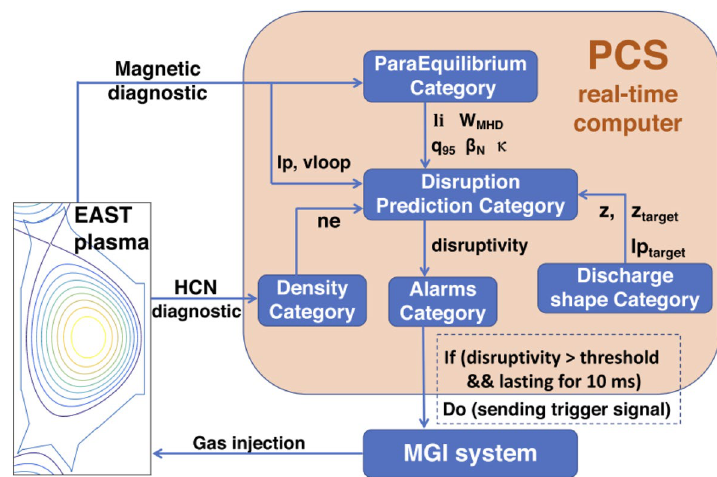
Fig. 10 The disruption prediction category implemented in the real-time computer of EAST PCS (from Ref